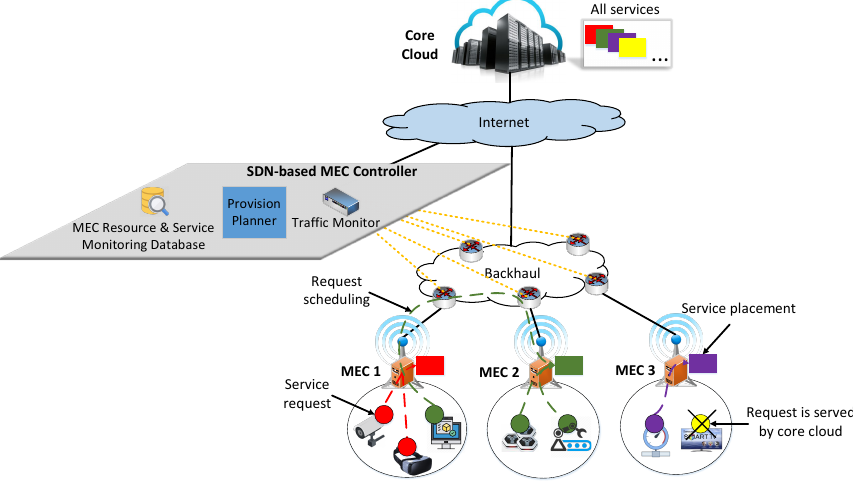
Figure 1. System model, where colored rectangles and circles represent different types of services and their user requests,